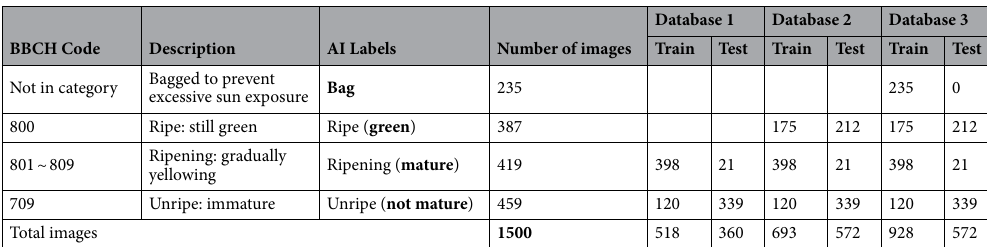
Table 4. Database categories and number of images based on BBCH code. Significant values are in